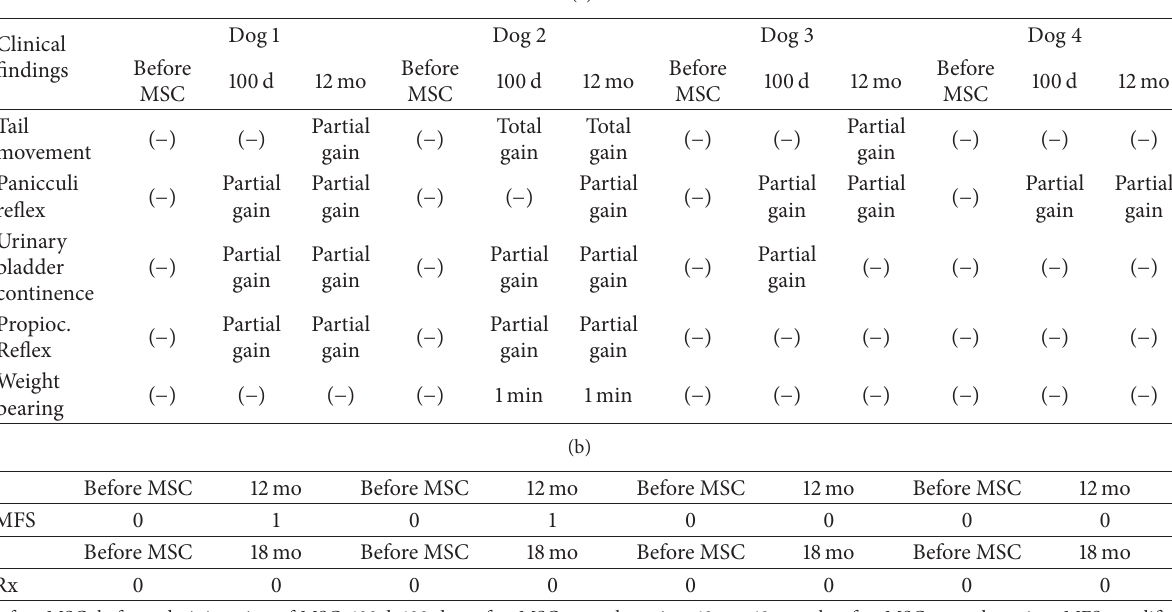
Table 2: Summary of clinical and imaging findings in dogs submitted to MSC.